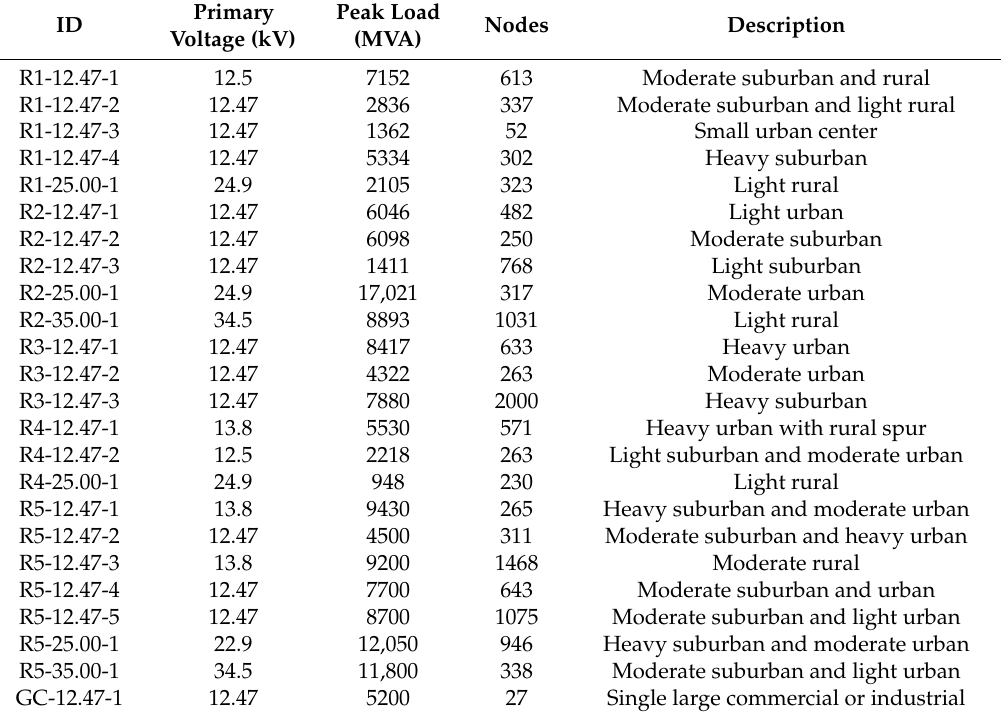
Table 2. Pacific Northwest National Laboratory (PNNL) Taxonomy